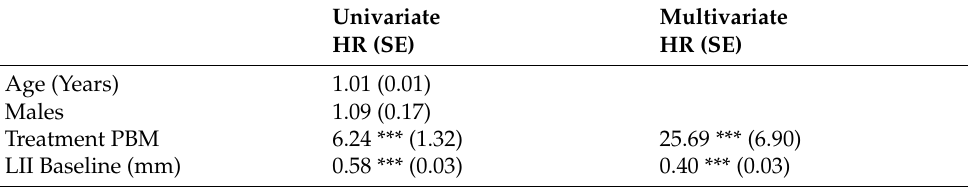
Table 2. Cox Proportional Hazard Models.